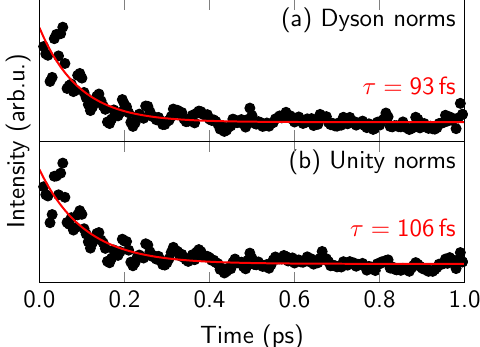
Figure 6. Integration of the simulated TRPES in Figure 3b for binding energies below 9.95 eV (i.e., 10.6 eV minus the estimated shift of 0.65 eV). Black dots show the integrated, temporally not broadened data, based on either Dyson norms or unity norms. The red curves are mono-exponential fits of the data, where the data in the first 20 fs (containing the large intensity spike at the Franck–Condon point) were excluded from the fit.